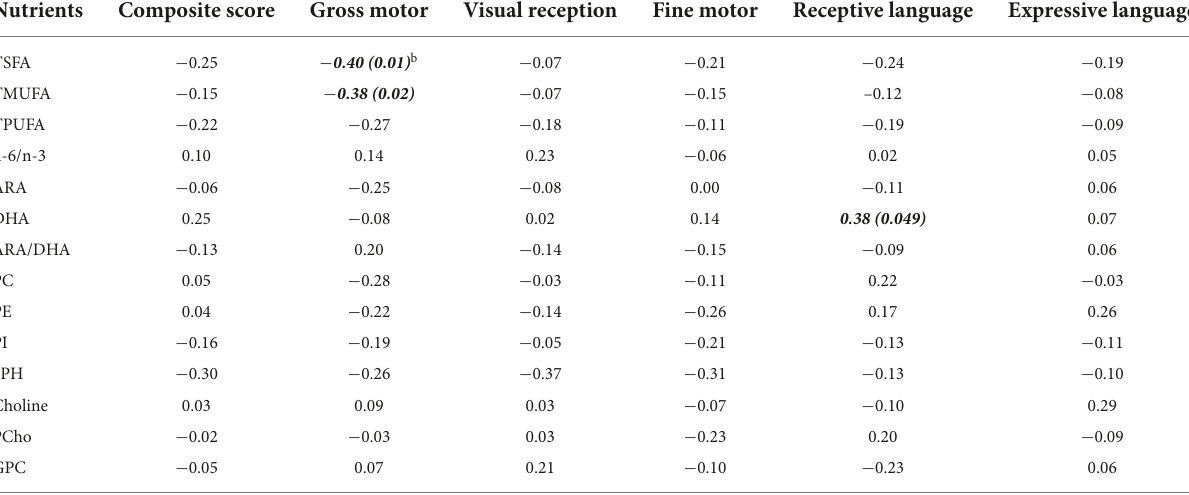
TABLE 3 Standardized regression coefficients of the human milk nutrients with the Mullen Scales of Early Learning scores. a